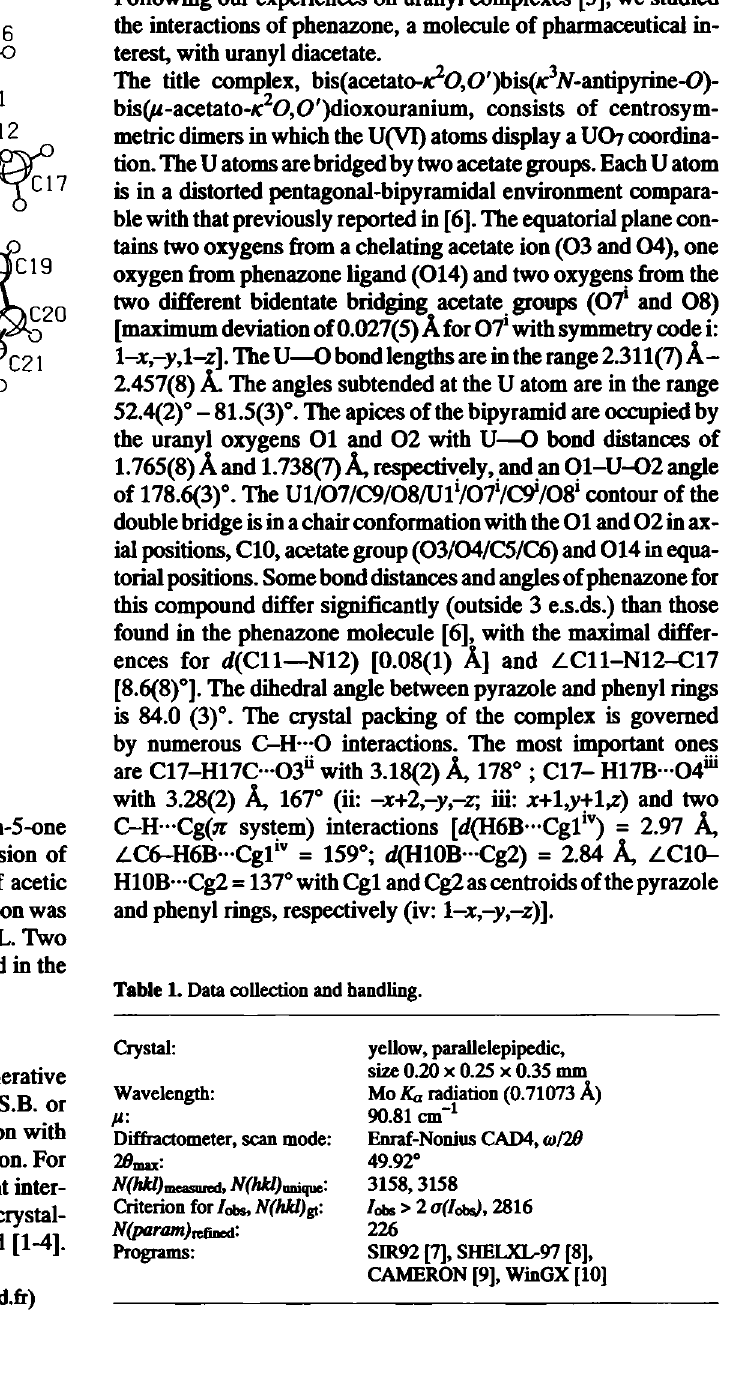
Table 1. Data collection and